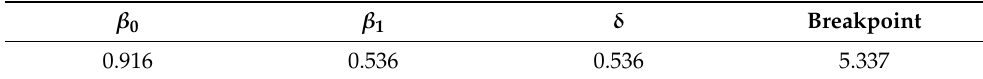
Table 5. The result of the segmented mixed